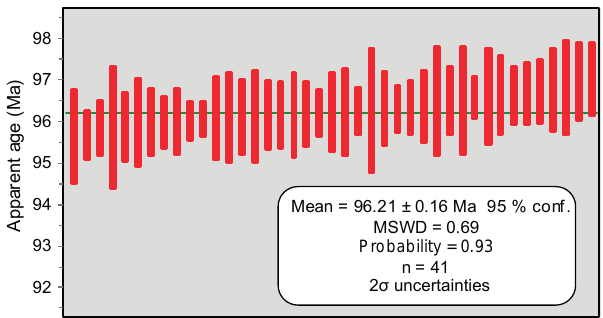
Figure 6. Summary of 40 Ar / 39 Ar